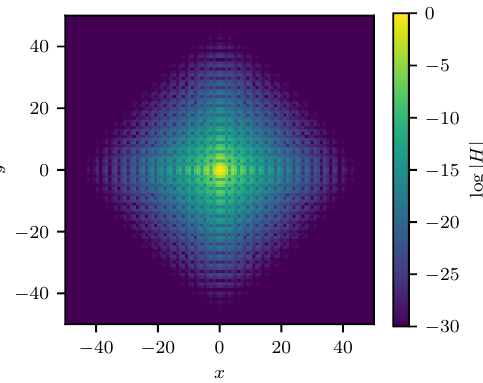
Figure 2: Magnitude of hopping matrix elements in the modified KM Hamiltonian with constant Berry curvature, as function of relative site positions.